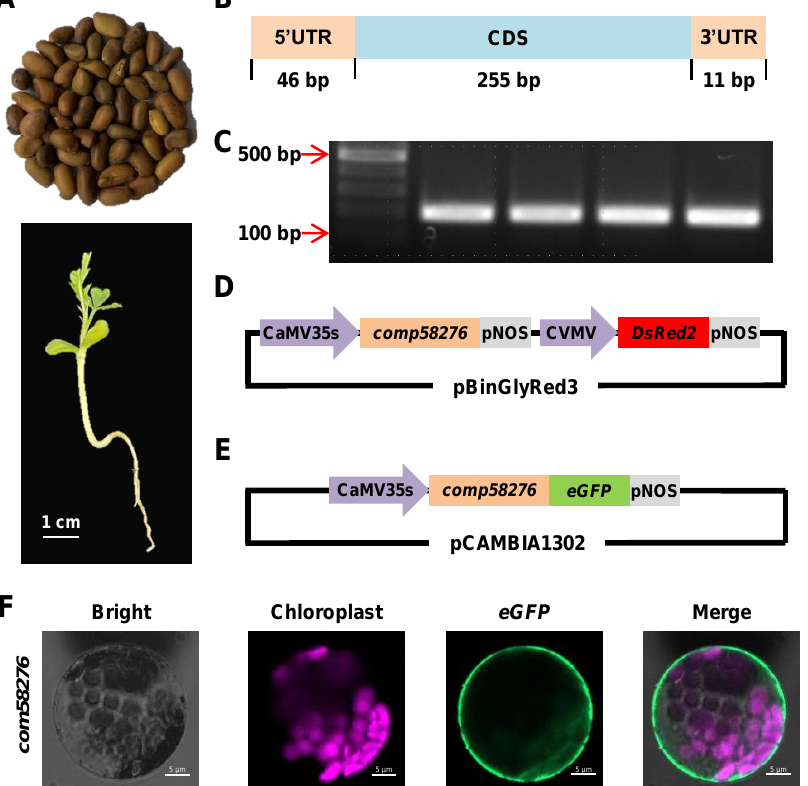
Figure 1. Cloning of C. korshinskii com58276 , vector information, and subcellular localization. ( A ) C. korshinskii seeds and seedlings. Scale bars = 1 cm. ( B ) Gene structure. ( C ) Clone com58276 by RT-PCR. ( D ) The com58276 overexpression vector. ( E ) The com58276 subcellular localization vector. ( F ) Subcel- lular localization assay of pCaMV35S::COM58276-eGFP in cotton protoplast. Pink fluorescence is chloroplast auto-fluorescence. Scale bars = 5 µ